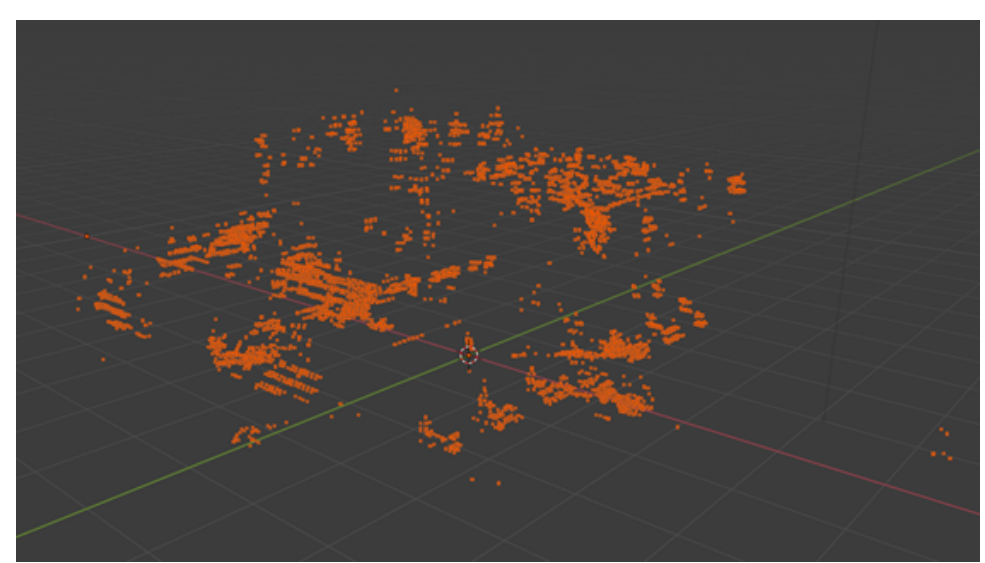
Figure 13. Point cloud for Leopard tank derived from SAR images obtained by SARCASTIC simulation. Eight point clouds from equally spaced illumination angles over 360 degrees have been combined.